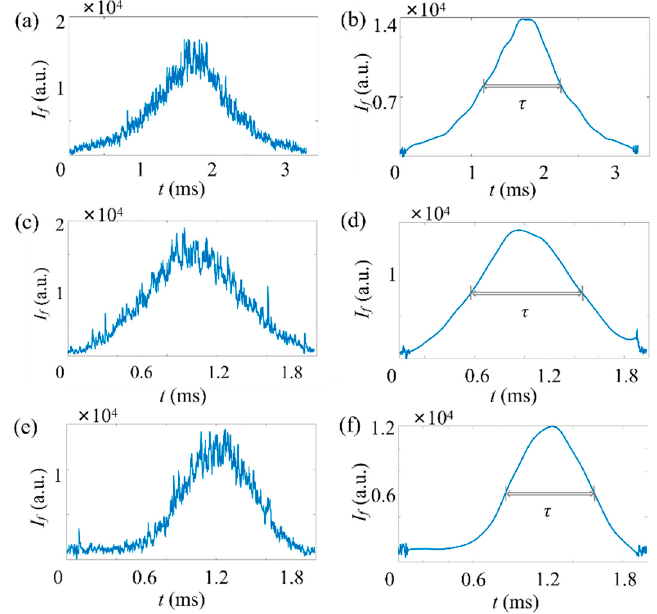
Figure 8. Typical time traces of fluorescence signals of micropillars in a low particle concentration, ∼ 10 7 mL − 1 . Here, Q s = Q = 1 µ L/h. The horizontal axis represents the time, and the vertical axis represents the signal strength. Here, a moderate gain is applied for the PMT. ( a , c , e ) Raw data and ( b , d , f ) data after noise reduction. ( a , b ) Time trace of micropillar with d p = 1.09 µ m. ( c , d ) Time trace of micropillar with d p = 0.73 µ m. ( e , f ) Time trace of micropillar with d p = 0.39 µ m.